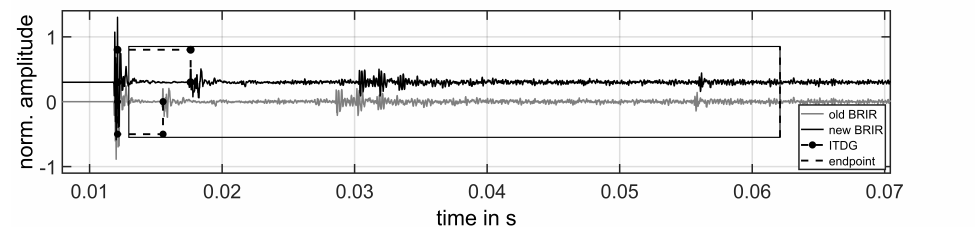
Figure 7. Shaping of a BRIR based on the initial time delay gap (ITDG) as an exemplary illustration. The box indicates the audio samples of the early reflections which are manipulated. Dashed lines indicate direct sound, first reflection, and endpoint of manipulation. A distant-dependent energy adaptation is not shown (figure after Füg et al.